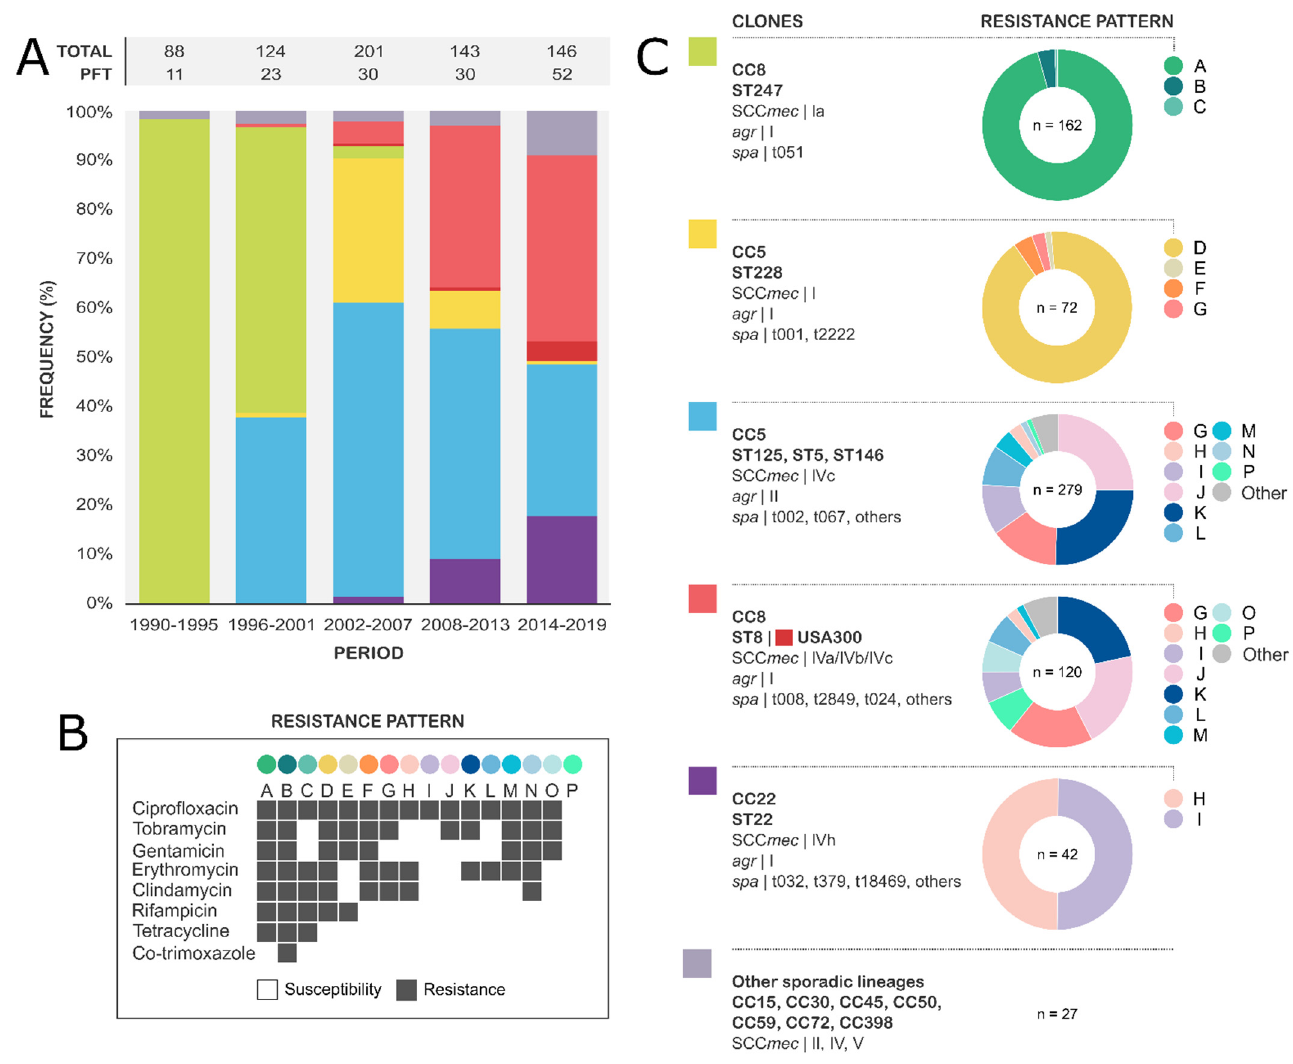
Figure 2. Evolution of MRSA-BSI clones and antimicrobial resistance patterns. ( A ) Distribution and frequency of MRSA-BSI lineages by period. The total number of MRSA-BSI isolates and the different PFGE types in each period are shown above bars. Clones are represented by coloured bars in ( A ) and by coloured squares in ( C ). ( B ) Resistance profiles of MRSA-BSI strains . ( C ) Molecular characterisation of major clones and their resistance profiles. The resistance profile of the major clones is represented by coloured dots in ( B , C ). Other minor resistance profiles ( n < 5) are shown as ‘Other’. CC, clonal complex; PFT, pulsed-field type; SCC mec , staphylococcal chromosomal cassette mec ; spa , spa -type; ST, sequence type; agr , accessory gene regulator